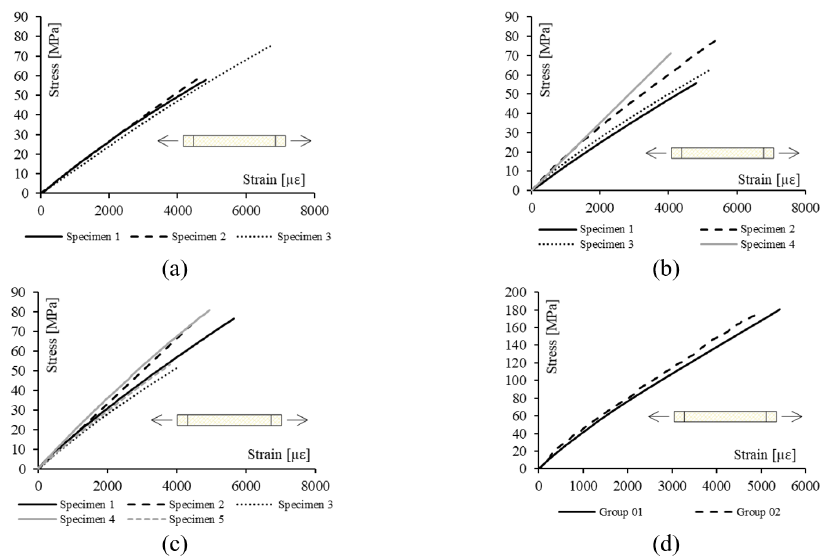
Figure 9. Experimental stress-strain curves: (a) longitudinal tensile modulus of elasticity for Group 01; (b) longitudinal tensile modulus of elasticity for Group 02; (c) longitudinal tensile modulus of elasticity for Group 03; (d) transversal tensile modulus of elasticity for Groups 01 and 02.